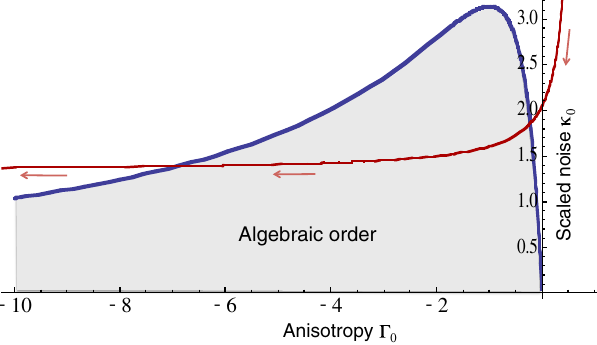
FIG. 3. Phase diagram of a generic anisotropic system exhibit- ing reentrance. The thin line marks the natural trajectory in an experiment in which only the pump power is varied. The arrows mark the direction of increasing pump power. Such an experiment will see a reentrant behavior, where the system starts in a disordered state, enters the power-law superfluid, and then goes back to a disordered state. Here, we have used the two-band model of Appendix B with ¯ γ ¼ 1 = 2 , ¯ u ¼ 2 , ν ν ¼ 1 = 4 y